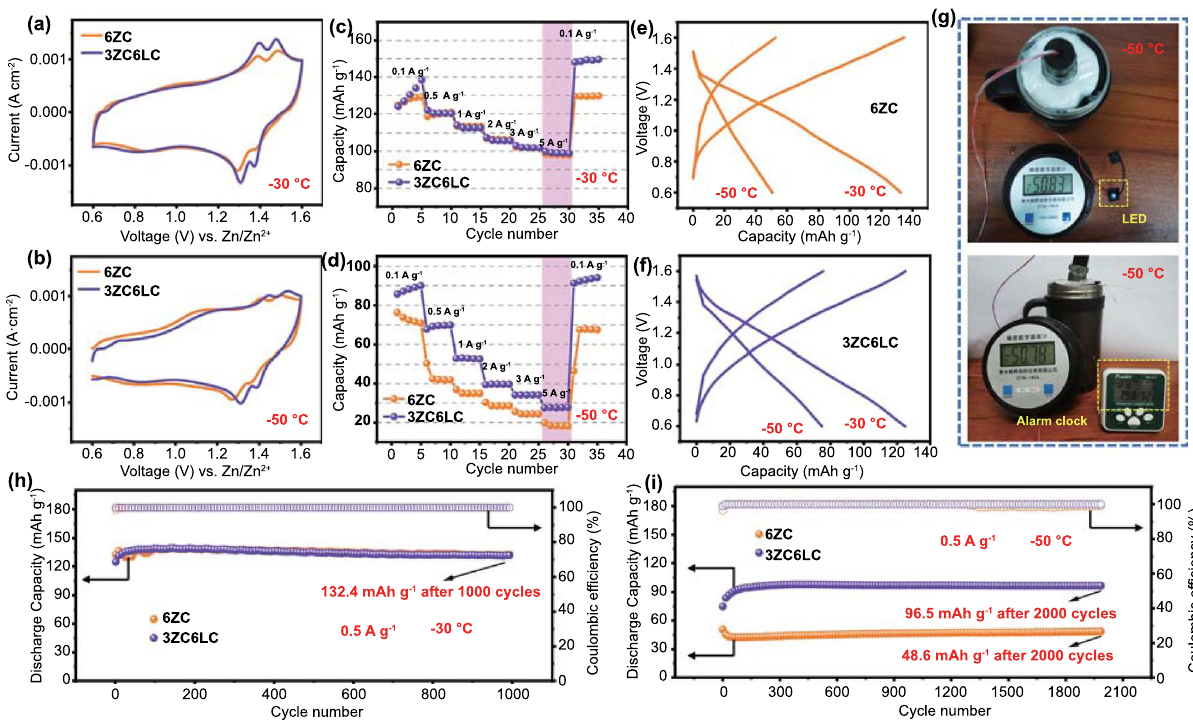
Fig. 6 CV curves of PANI/Zn cells in various electrolytes at a −30 °C and b −50 °C (2 mV s −1 ). Rate performance of the PANI/Zn cells at c −30 °C and d −50 °C. Charge–discharge profiles (0.5 A g −1 ) of the PANI/Zn cells at e -30 °C and f -50 °C. g The photos of a LED and an alarm clock powered by three PANI/Zn coin cells connected in series at -50 °C. Cycling performance and coulombic efficiency of the PANI/Zn cells using 6ZCand 3ZC6LC at h -30 °C and i -50